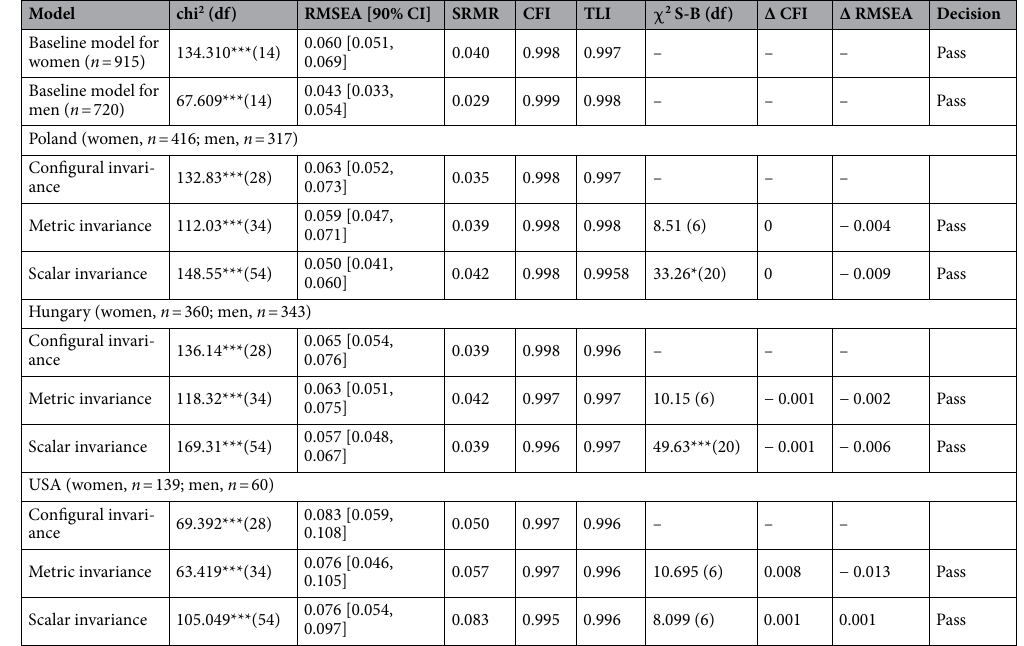
Table 3. Model fit for multiple group by gender models and measurement invariance comparisons. CFI comparative fit index, TLI Tucker–Lewis index, RMSEA root mean square error of approximation, CI confidence interval, df degrees of freedom, SRMR squared root mean residuals; S–B Satorra–Bentler correction, Δ comparisons of nested model: configural-metric, metric-scalar. In the U.S. sample, one outlier was excluded due to Cook’s distance above 1. *p < 0.05, ***p <